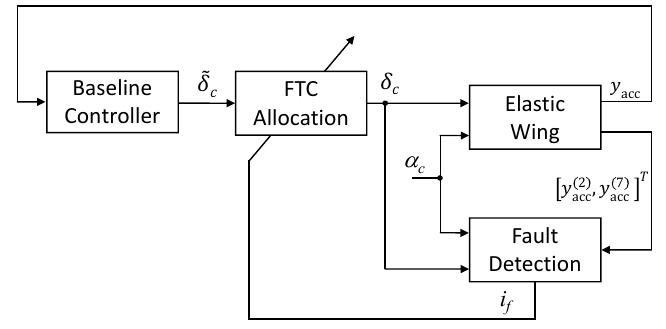
Figure 5. Schematic illustration of the fault tolerant control